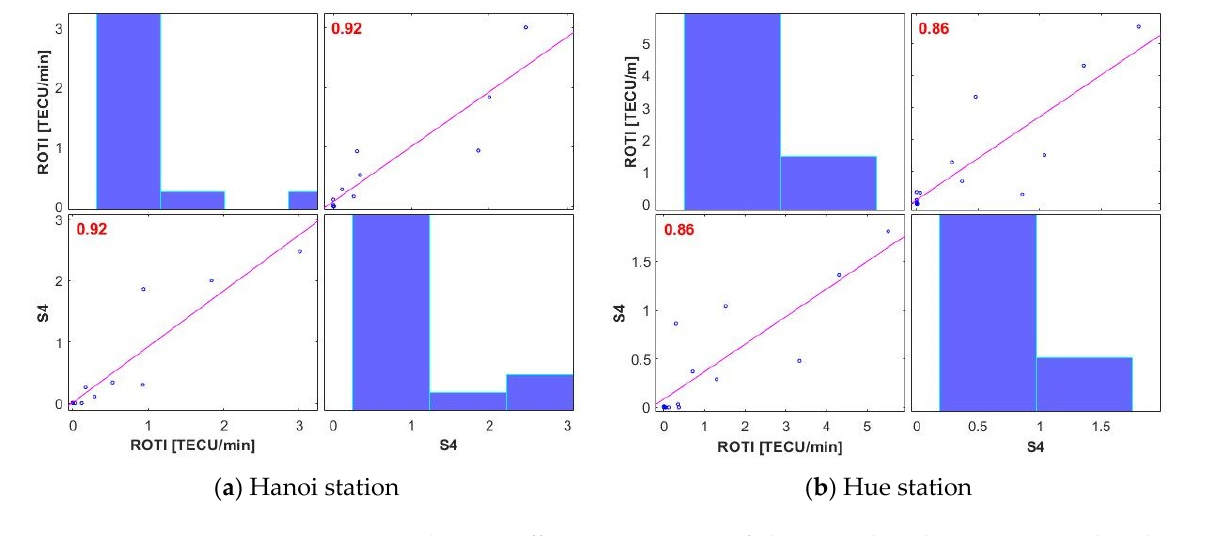
Figure 5. Correlation coefficient (percentage of electronic disturbances compared to the total of the observations) between ROTI and S4 at Hanoi ( a ) and Hue ( b ) stations during the period of 15–28 March 2015. The similarity between these two indices at Hanoi station is 0.92, slightly higher than at Hue station with 0.86. Both of these indices demonstrate good conformity between ROTI and S4 indices.